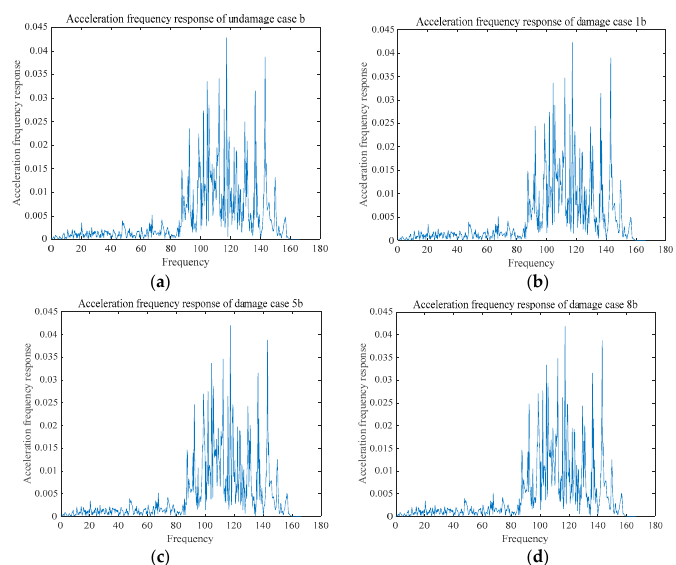
Figure 11. Acceleration frequency response of Group A: ( a ) UDMa; ( b ) DMG1a; ( c ) DMG5a; and, ( d ) DMG8a.